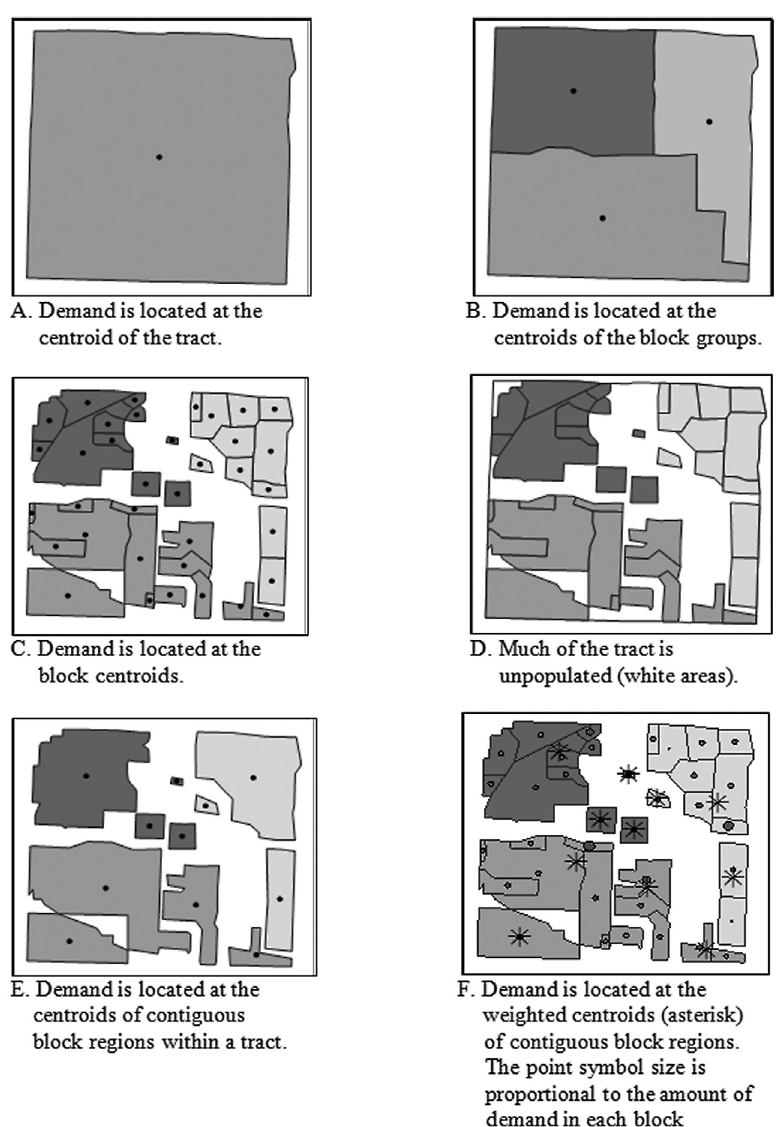
Fig. 1. Demand representations used in the